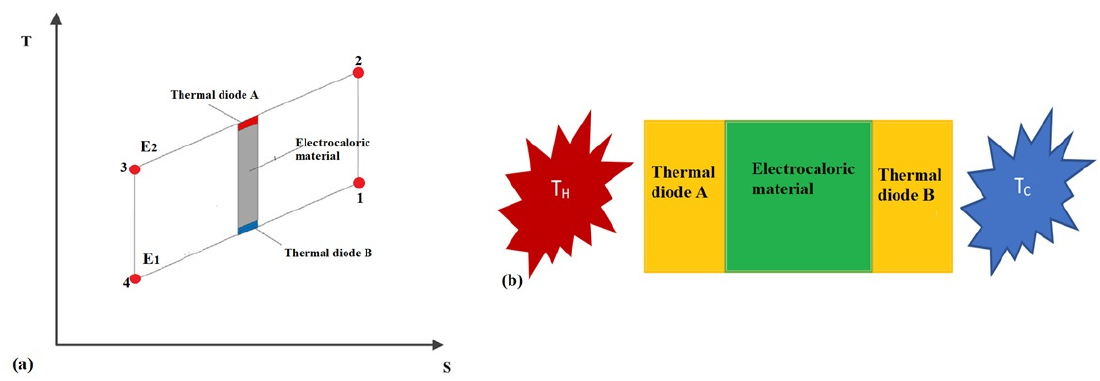
Figure 7. ( a ) The electrocaloric thermal diode cycle on T-S diagram; ( b ) scheme of principles of the electrocaloric thermal-diode system for cooling.